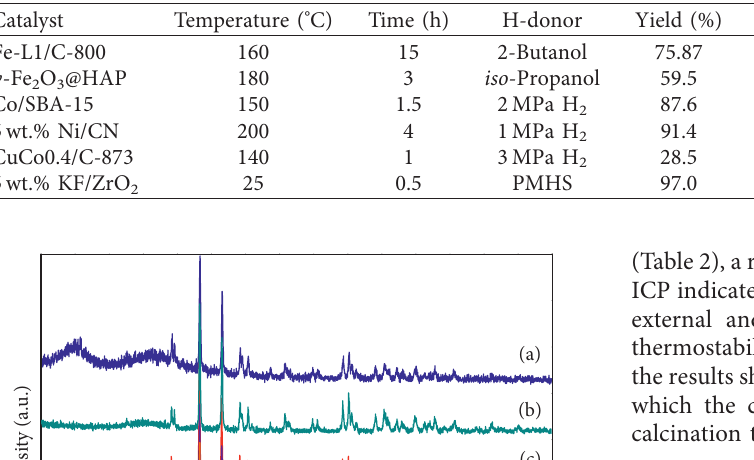
Table 1: Catalytic results collected for the hydrogenation of FUR to FFA.